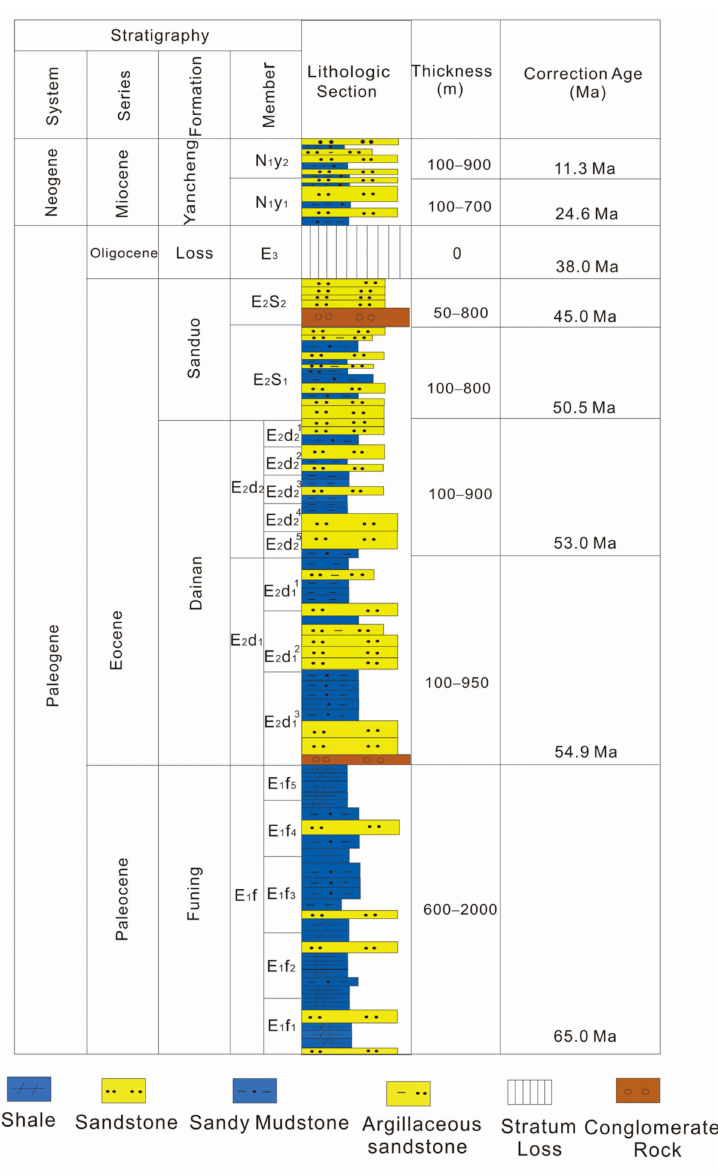
Figure 2. Comprehensive stratigraphic column of the Gaoyou